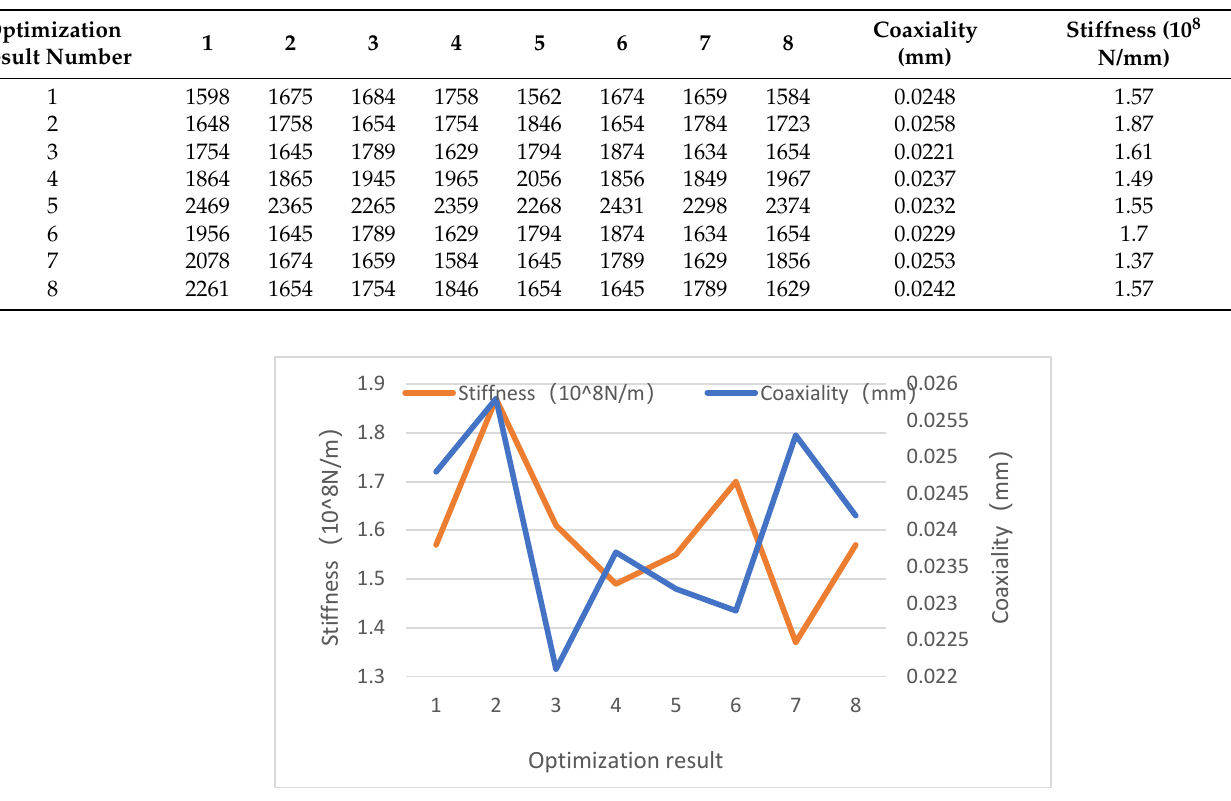
Figure 14. Optimization results.